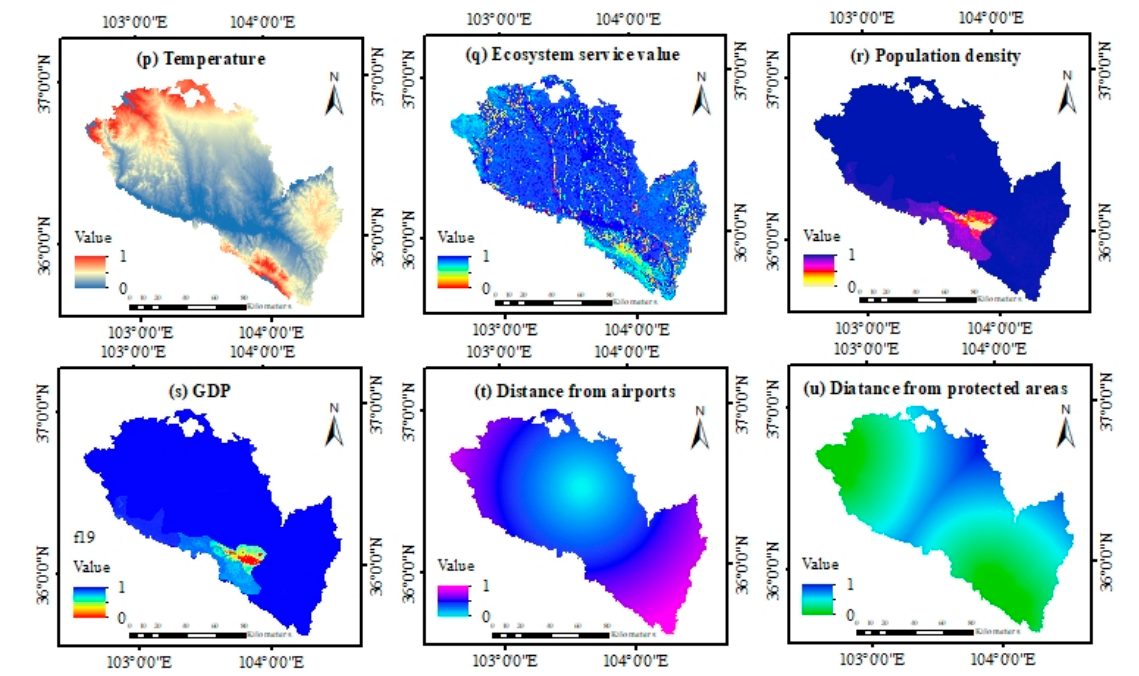
Figure 3. 21 Criteria included ( a ) groundwater depth, ( b ) groundwater quality, ( c ) groundwater richness, ( d ) distance from faults, ( e ) distance from earthquake points, ( f ) elevation, ( g ) slope, ( h ) soil type, ( i ) NDVI, ( g ) landform type, ( k ) distance from surface water, ( l ) distance from roads, ( m ) land use type, ( n ) distance from settlements, ( o ) precipitation, ( p ) temper ‐ ature, ( q ) ecosystem service value, ( r ) population density, ( s ) GDP, ( t ) distance from airports, ( u ) distance from protected areas.